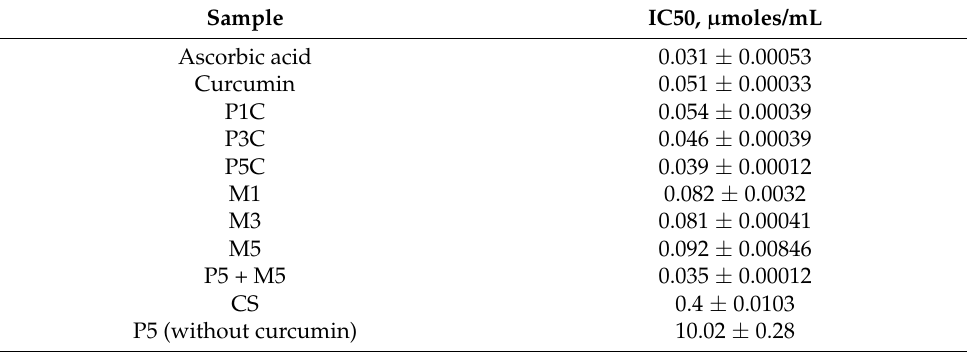
Table 2. Antioxidant activity expressed by IC50 for the analyzed samples.